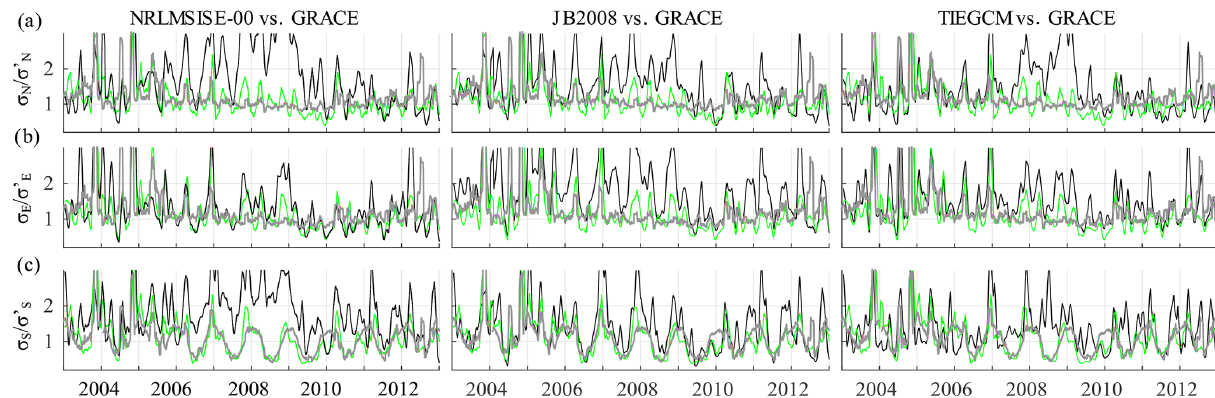
Figure 8. From top to bottom, the solar-flux normalized 30d standard deviation sliding window of residual density disturbances at an altitude of 475km ( ρ r ) in (a) the northern, (b) the equatorial, and (c) the southern regions, for NRLMSISE-00 (left), JB2008 (center), and TIEGCM (right) models. Data from GRACE (green color) and Fourier fits in terms of doy and E m (gray) from Fig. 4 are included for comparison. Only variations between 1 and 10d are